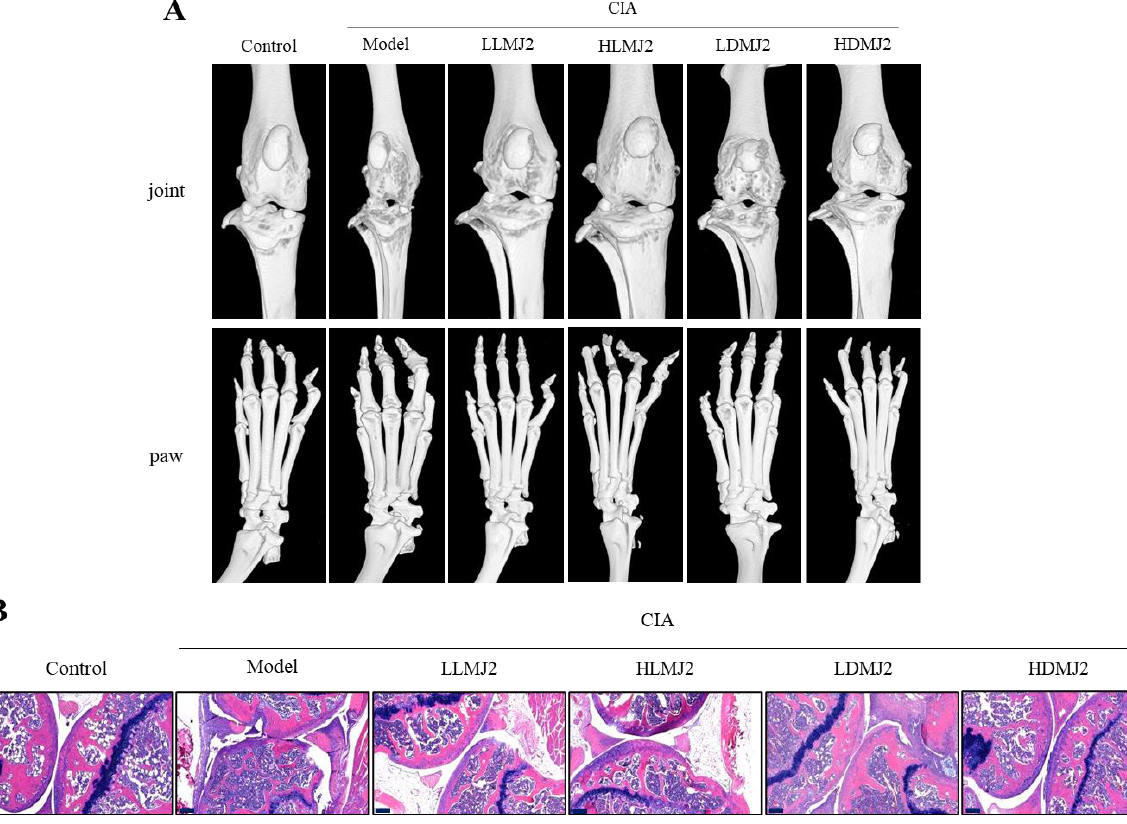
Figure 5. Ameliorative effect of MJ2 on bone erosion in CIA mice ( n = 8 per group). Mice knee joint and paw were observed by micro-CT. Representative images of mice knee and paw ( A ). The inflammation in the mice knee joint was observed by hematoxylin-eosin staining ( B ) (100×, scale bar = 200 μm). Data values indicate the mean ± standard error of the mean (SEM). One way ANOVA followed by Tukey’s HSD was used to determine significance. CIA, collage-induced arthritis. Table 4. Bone parameters in CIA mice measured by micro-CT ( n = 8 per group).